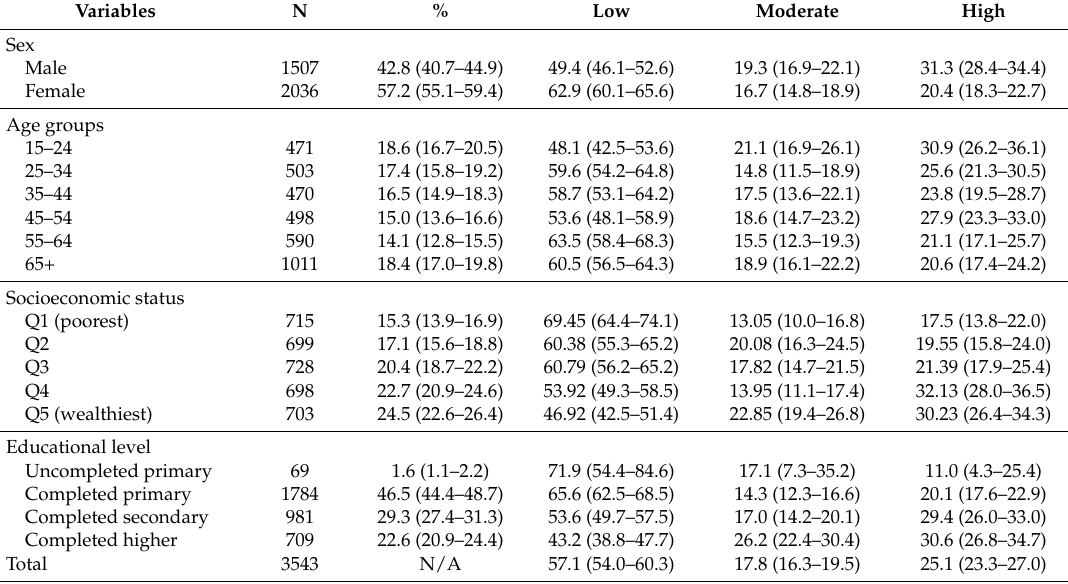
Table 1. Sample description and leisure time physical activity (LTPA) prevalence according to socio-demographic